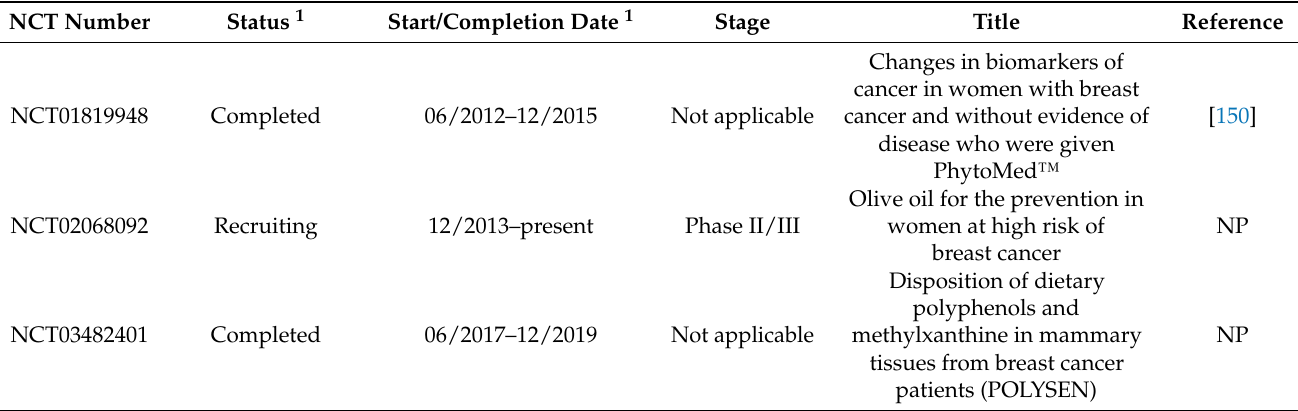
Table 8. Clinical trials with hydroxytyrosol in breast